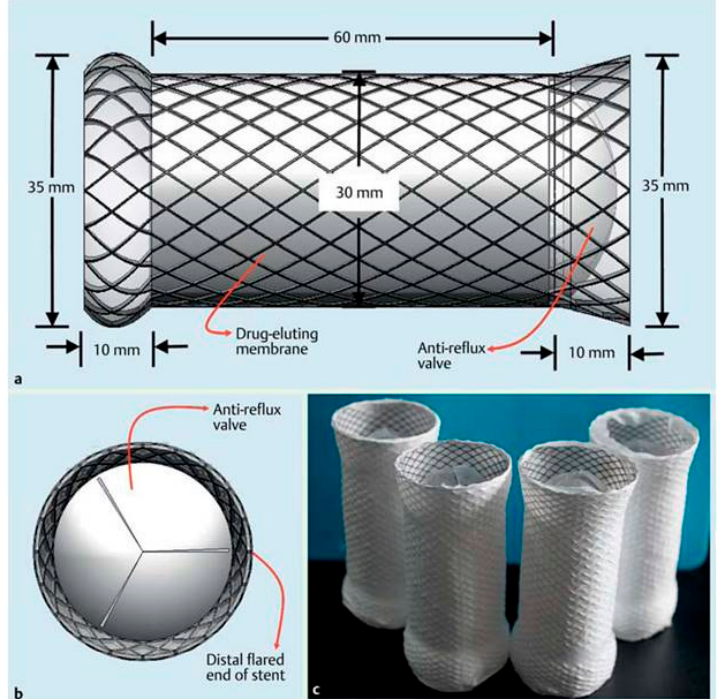
Figure 7. Diagrammatic and real representation of rapamycin-eluting stents: ( a ) the lateral view of the fully expanded bare cardia stent and its design parameters; ( b ) the antero-apical view of a schematic diagram of a stent with a trisected offset valve designed to prevent reflux and to allow smooth passage of food; and ( c ) overview of the fully expanded rapamycin-eluting stent [85]. Copyright permission from Thieme.